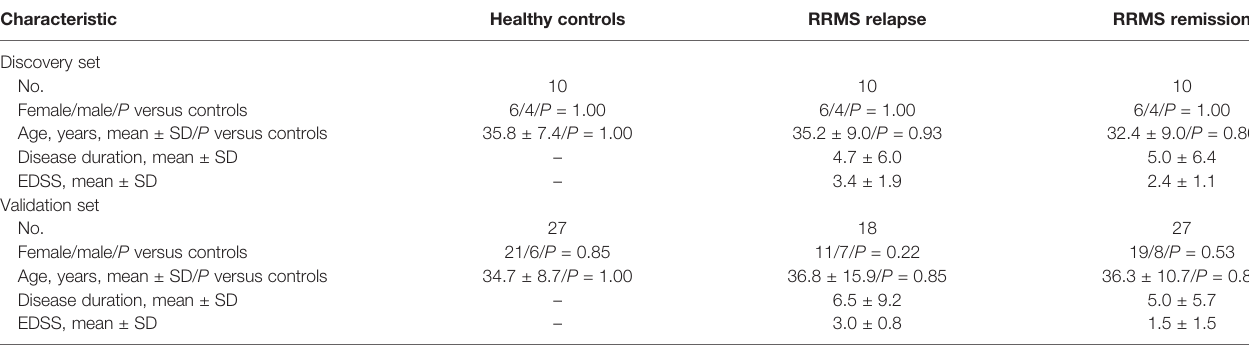
TABLE 1 | Main characteristics of the individuals enrolled in the study. Characteristic Healthy